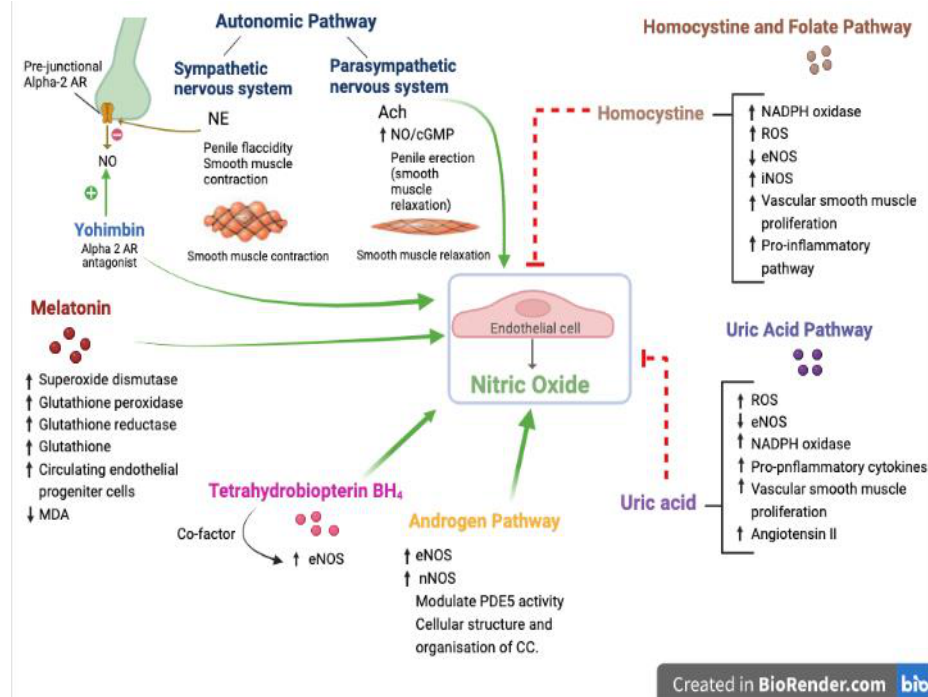
Figure 1. Pharmacological pathways involved in erectile dysfunction. NE, norepinephrine; Ach, acetylcholine; NO, nitric oxide; cGMP, cyclic guanosine monophosphate; AR, adrenergic receptors; MDA, malondialdehyde; NOS, nitric oxide synthase; PDE, phosphodiesterase; CC, corpus cavernosum; NAPDH, nicotinamide adenine dinucleotide phosphate; ROS, reactive oxygen species. In ad-